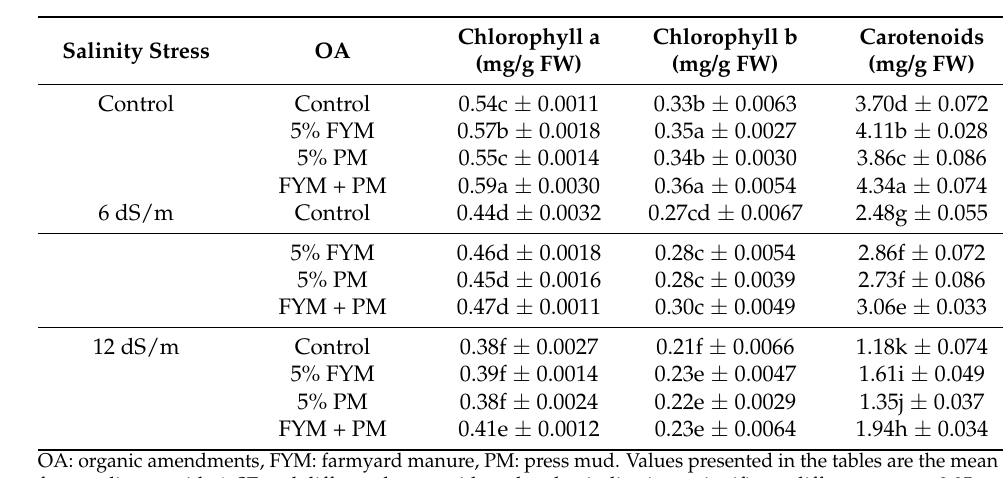
Table 2. Effect of different organic amendments on photosynthetic pigments under diverse salt stress levels.